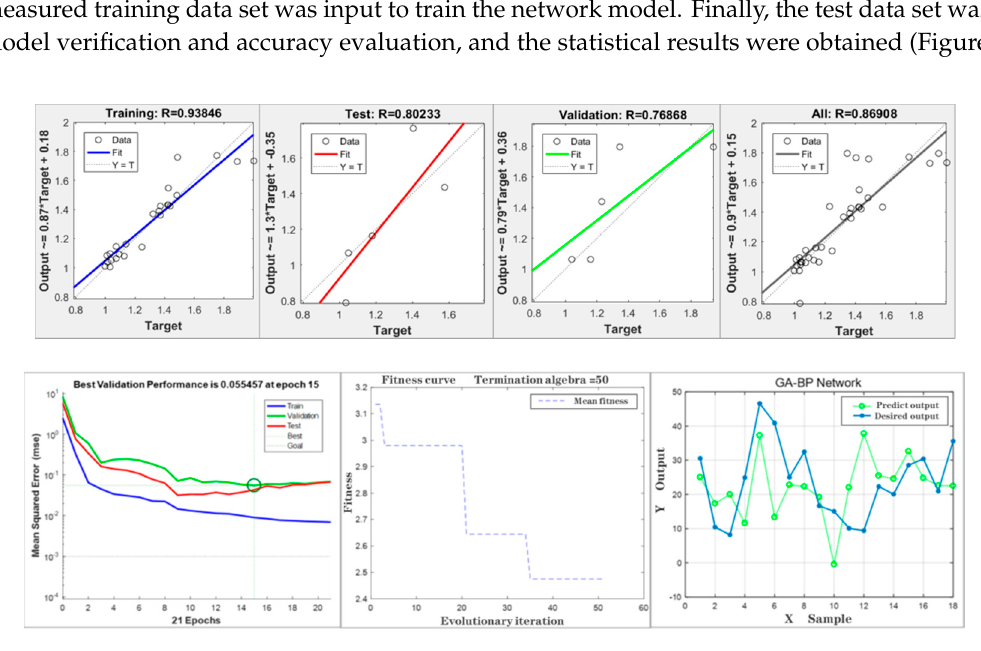
Figure 3. Regression statistics results ( top ) and Simulation result ( bottom ).